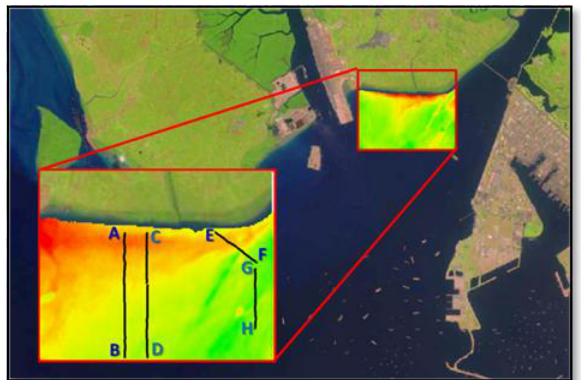
Figure 14. Location of the 4 different cross-shore profiles